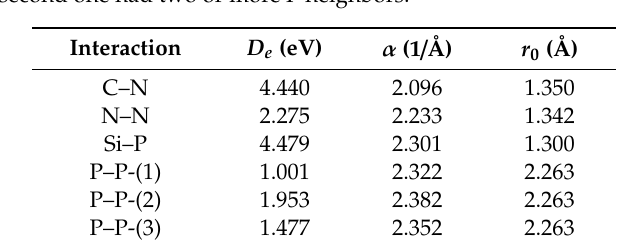
Table 2. Morse fitting parameters for the interatomic pair interactions. The cuto ff distance was 2.0 Å for C–C and C–N interactions and 3.0 Å for Si–P and P–P interactions. The three parameter sets for